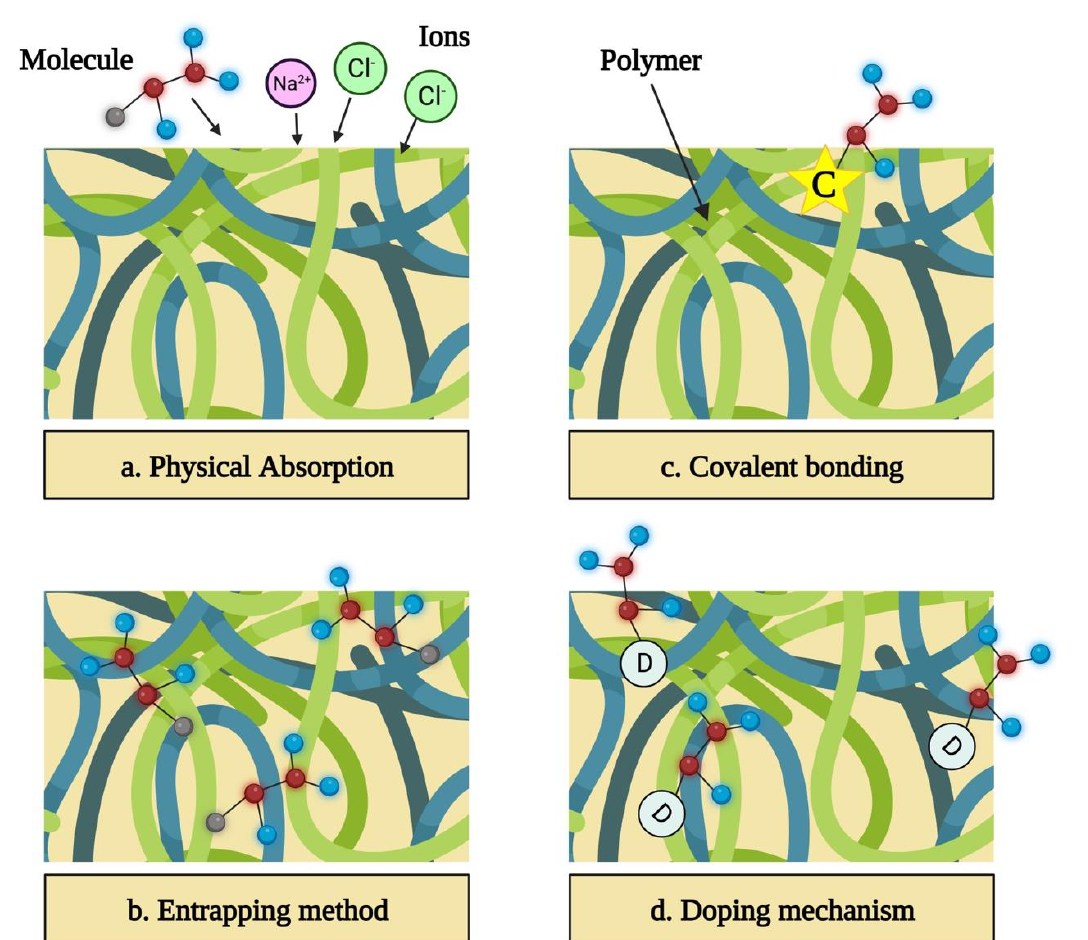
Figure 6. Functionalization of conductive polymers for specific applications.